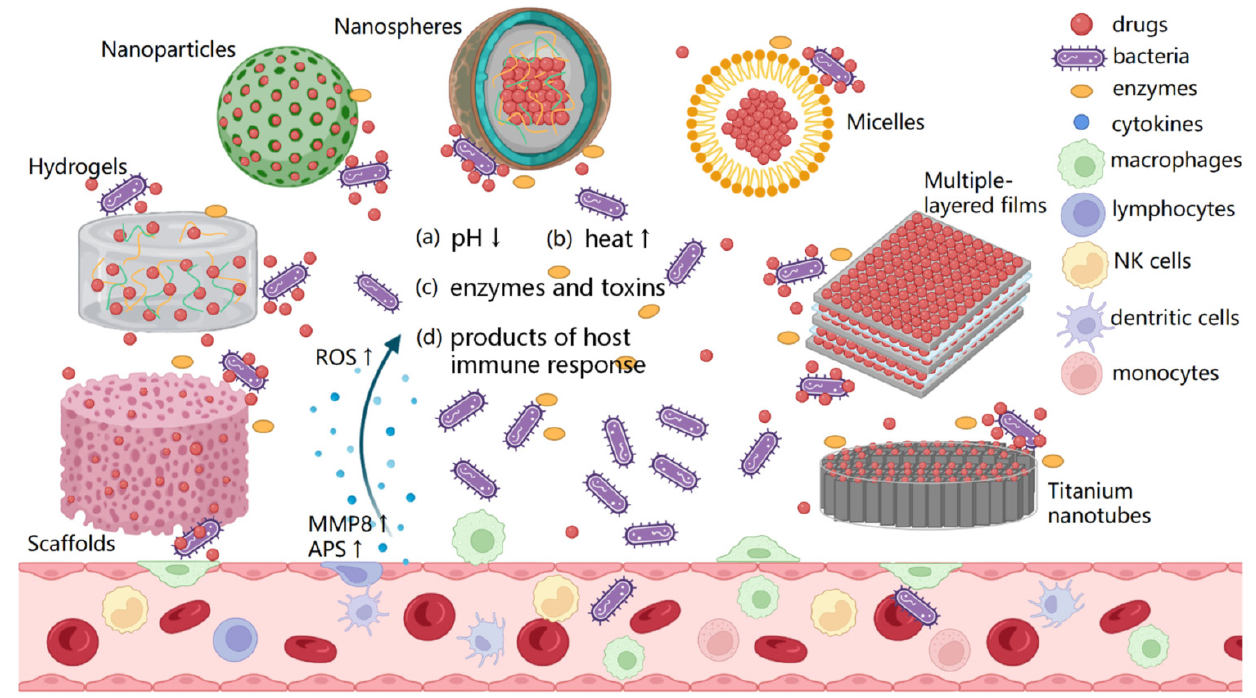
Figure 7. The schematic representation of smart bacteria-responsive drug delivery systems. Scaffolds, hydrogels, nanoparticles, nanosphere, micelles, multiple-layer films and TiO 2 NT loaded with drugs are triggered by the changes specific to the infection microenvironment, including the ( a ) pH decreasing, ( b ) elevated local temperature, ( c ) bacteria-specific enzymes and toxins and ( d ) products of host immune response, aiming to kill the bacteria. Reproduce and adapted from [150] under Creative Commons Attribution 4.0 International License (CC BY 4.0).